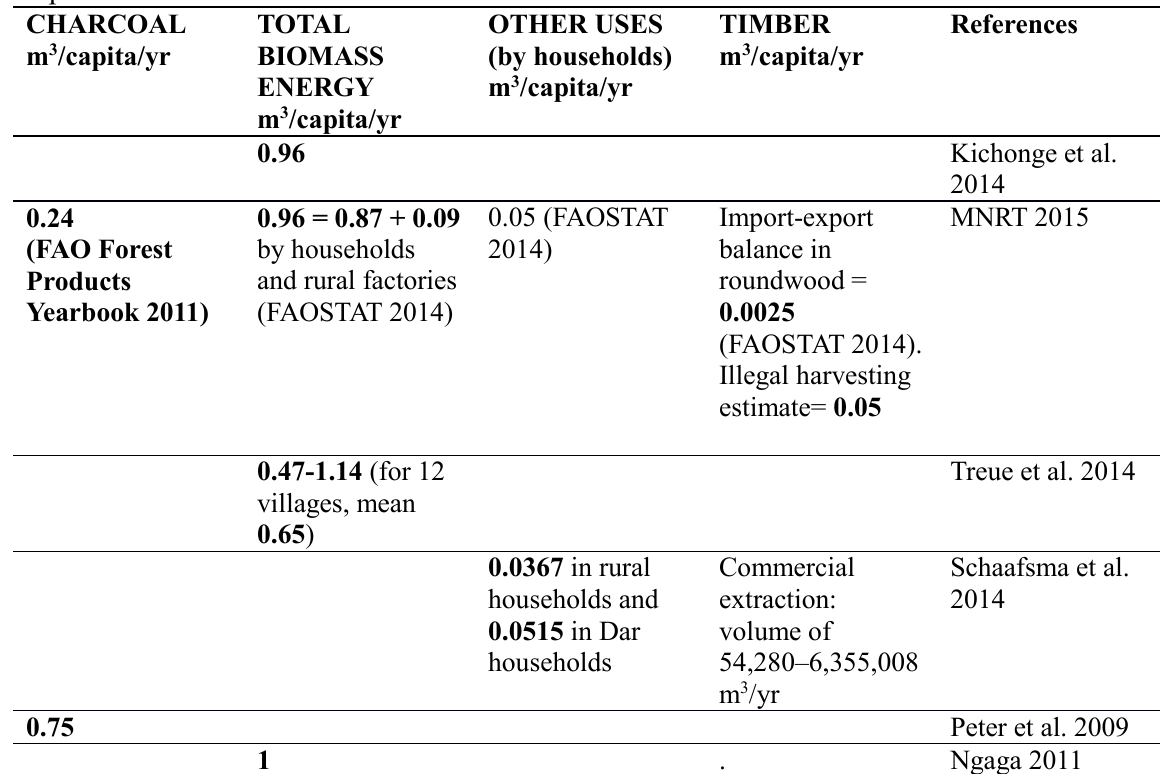
Table A2.4: Estimate of wood demand (m3/capita/yr) for for biomass energy and timber reported in